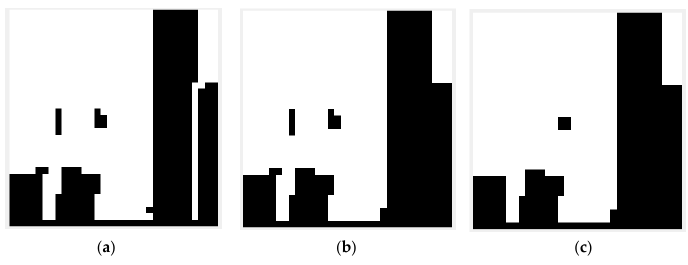
Figure 6. ( a ) Initial image I ( t ); ( b ) morphological opening; ( c ) morphological closing.